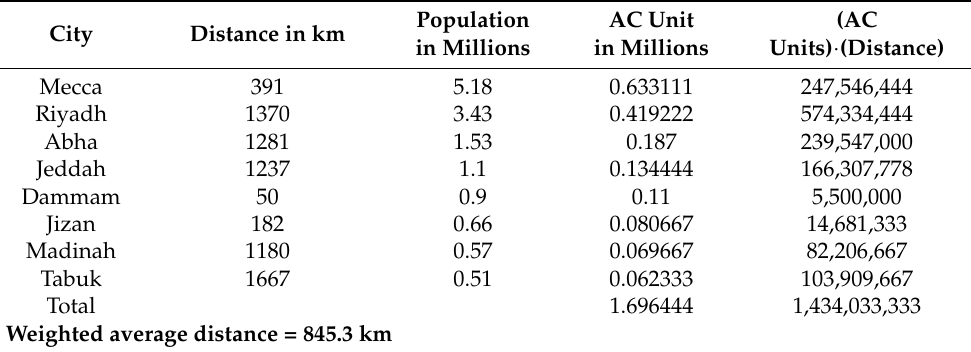
Table 1. The distances between the major KSA cities and remanufacturing plant. Population AC Unit (AC City Distance in km in Millions in Millions Units) · (Distance) Mecca 391 5.18 0.633111 247,546,444 Riyadh 1370 3.43 0.419222 574,334,444 Abha 1281 1.53 0.187 239,547,000 Jeddah 1237 1.1 0.134444 166,307,778 Dammam 50 0.9 0.11 5,500,000 Jizan 182 0.66 0.080667 14,681,333 Madinah 1180 0.57 0.069667 82,206,667 Tabuk 1667 0.51 0.062333 103,909,667 Total 1.696444 1,434,033,333 Weighted average distance = 845.3